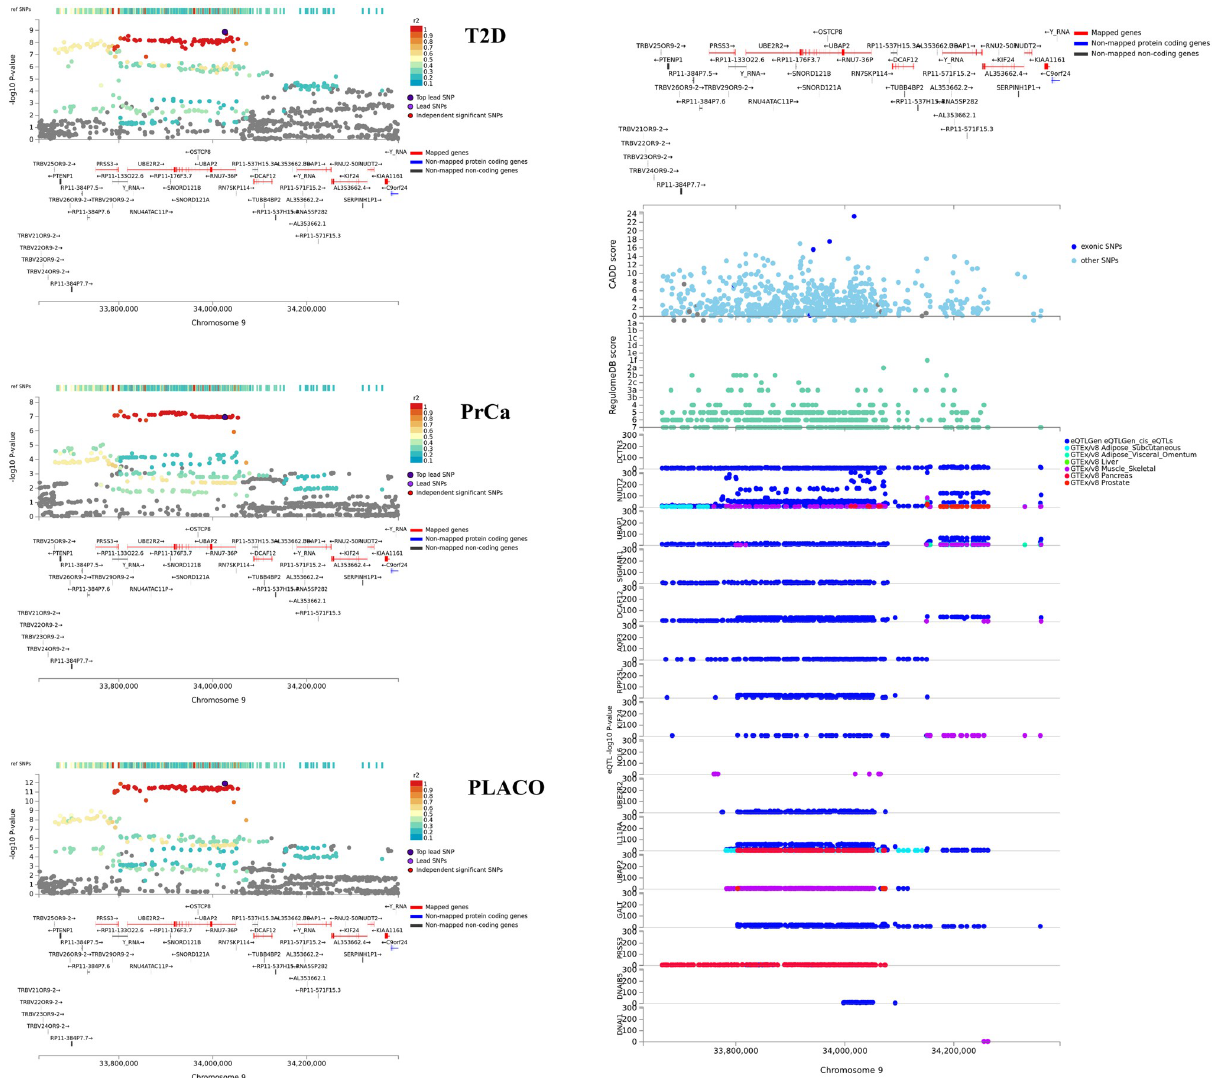
Fig 6. Regional association plot of significant pleiotropic locus near UBAP2 with annotations such as CADD scores, RegulomeDB scores, and cis eQTL association p-values from 6 tissues. Tissues considered are whole blood from eQTLGen Consortium; and adipose, liver, muscle-skeletal, pancreas, and prostate tissues from GTEx